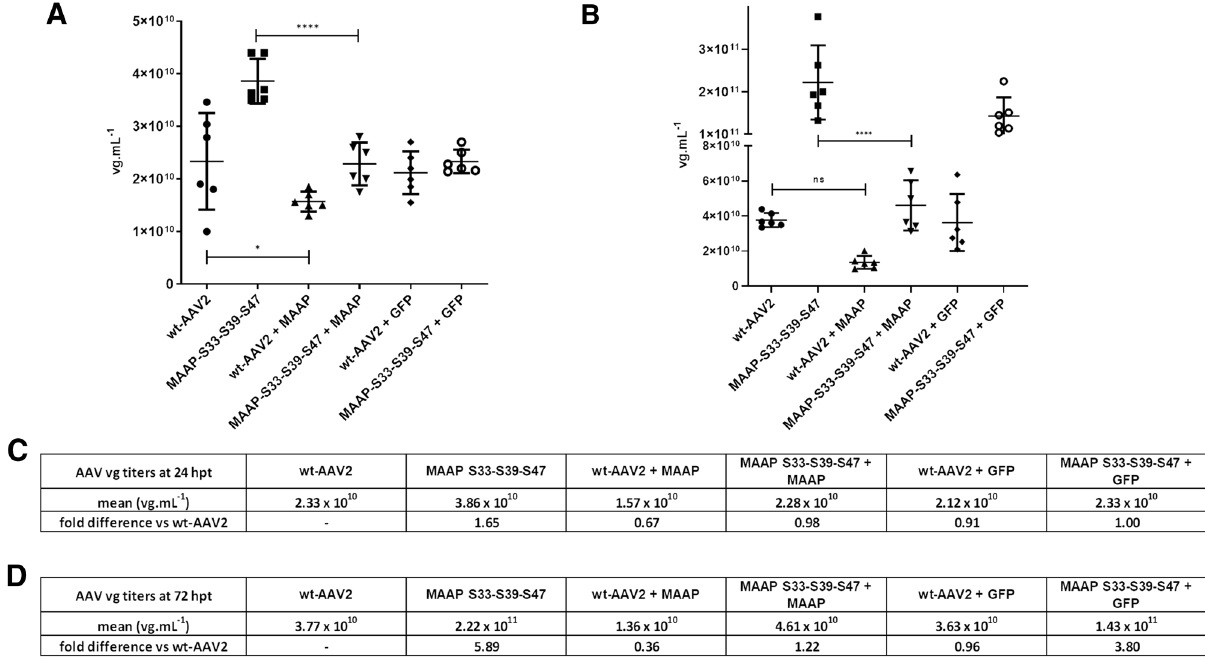
Figure 10. MAAP trans-complementation. We performed wt-AAV2 and MAAP-S33-S39-S47 variant production with or without the addition of recombinant MAAP. Vg titers (vg mL −1 ) were measured from cell extract samples harvested 24 hpt ( A ) and 72 hpt ( B ). Graphics show individual samples with mean and SD. Statistical significance was evaluated for recombinant MAAP addition using ANOVA followed by Dunnett’s multiple comparison test. Tables ( C ) and ( D ) represent the average titer (vg mL −1 ) at 24 hpt and 72 hpt, with fold difference to wt-AAV2. The samples from left to right are: (1) wt-AAV2. (2) MAAP-S33-S39-S47. (3) wt-AAV2 trans-complemented with MAAP expressing plasmid. (4) MAAP-S33-S39-S47 trans-complemented with MAAP expressing plasmid. (5) wt-AAV2 trans-complemented with a GFP plasmid of similar size to the recombinant MAAP plasmid. (6) MAAP-S33-S39-S47 complemented with a GFP plasmid of similar size to the recombinant MAAP